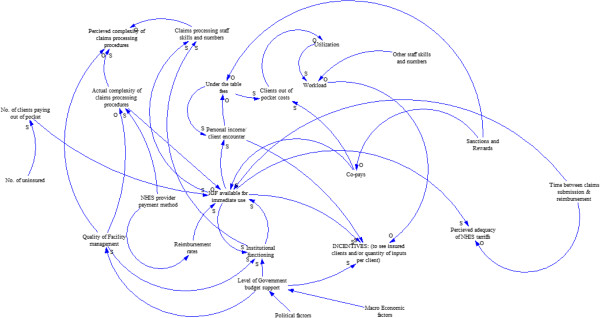
Causal loop diagram.